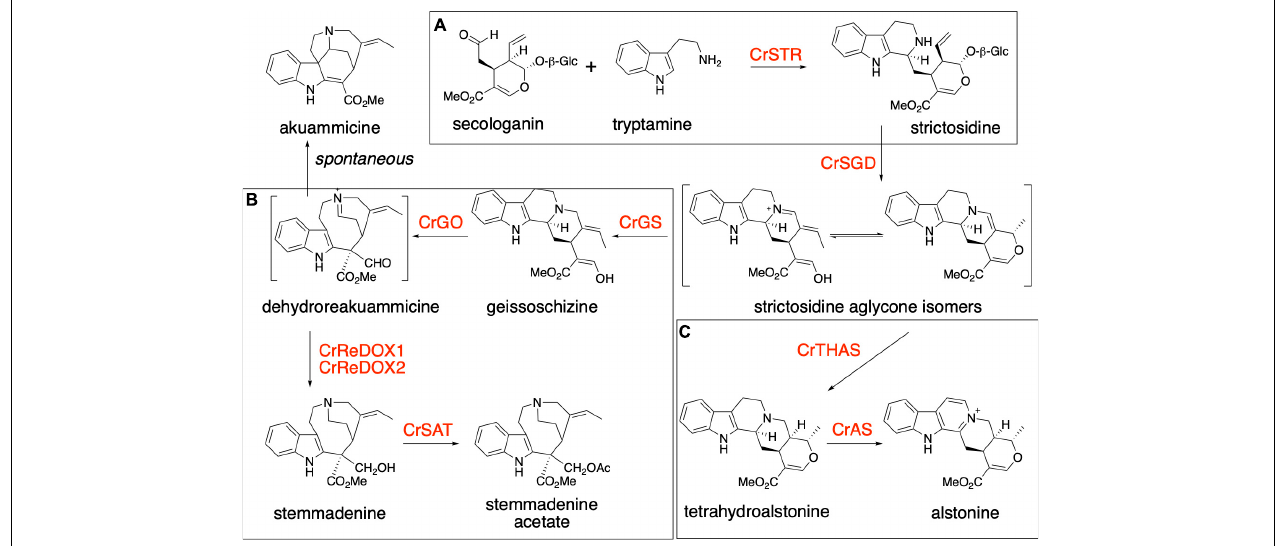
FIGURE 1 | Biosynthesis of monoterpene indole alkaloids. (A) Production of strictosidine from tryptamine and secologanin by the action of Catharanthus roseus strictosidine synthase (CrSTR). (B) Biosynthesis of stemmadenine acetate, an intermediate of the pathway for the production of the two anticancer compounds vinblastine and vincristine. The production of stemmadenine acetate involves 6 enzymes from strictosidine: CrSGD, CrGS, CrGO, CrReDOX1, CrReDOX2, and CrSAT. Akuammicine is a spontaneous degradation product of preakuammicine. (C) Biosynthesis of the antipsychotic molecule alstonine in Catharanthus roseus. The production of alstonine involves 3 enzymes from strictosidine: CrSGD, CrTHAS, CrAS.